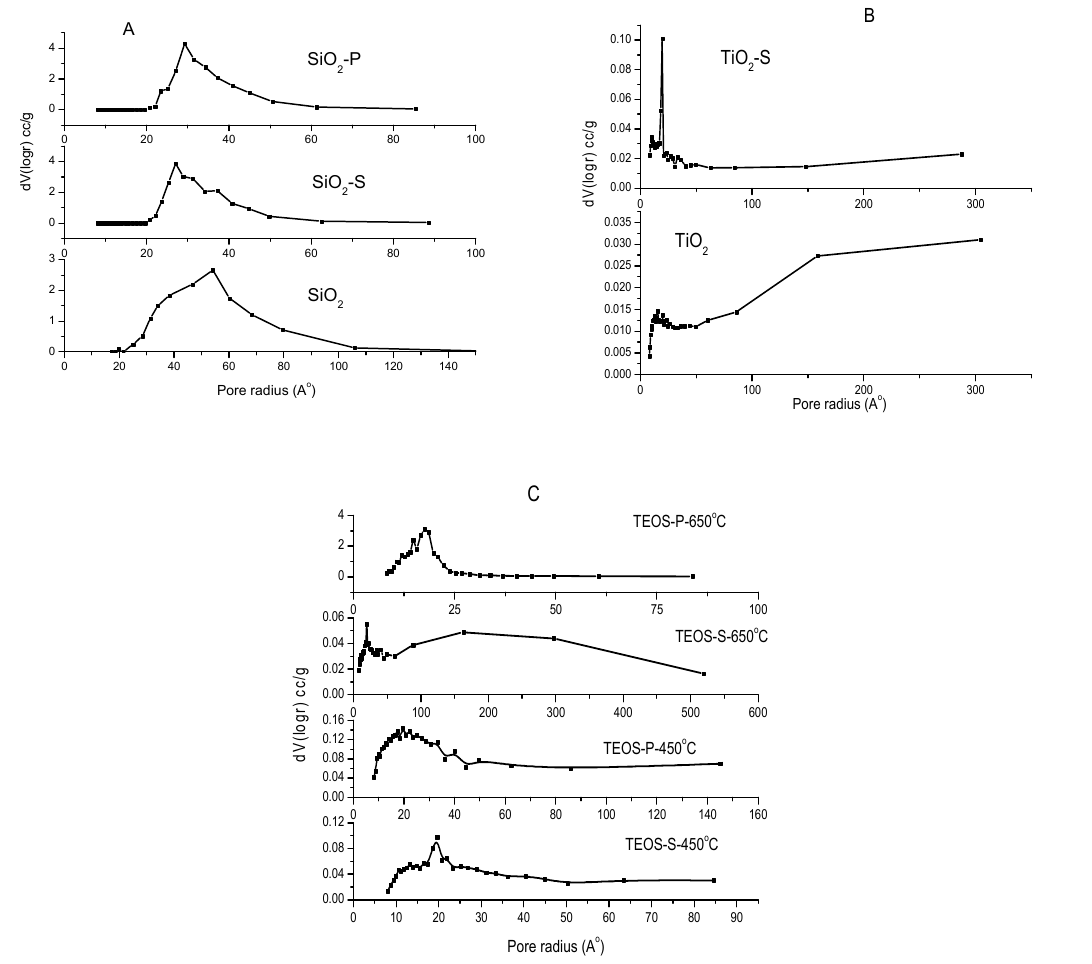
Figure 7. Pore size distribution BJH curves of different catalysts: plot ( A ) silica, sulfated silica and phosphated silica; plot ( B ) titania and sulfated titania; plot ( C ) silica prepared from TEOS treated with sulfuric and phosphoric acid calcined at 450 and 650 ◦